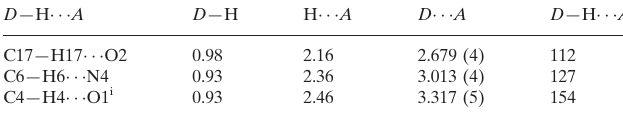
Hydrogen-bond geometry (A˚ , (cid:2)